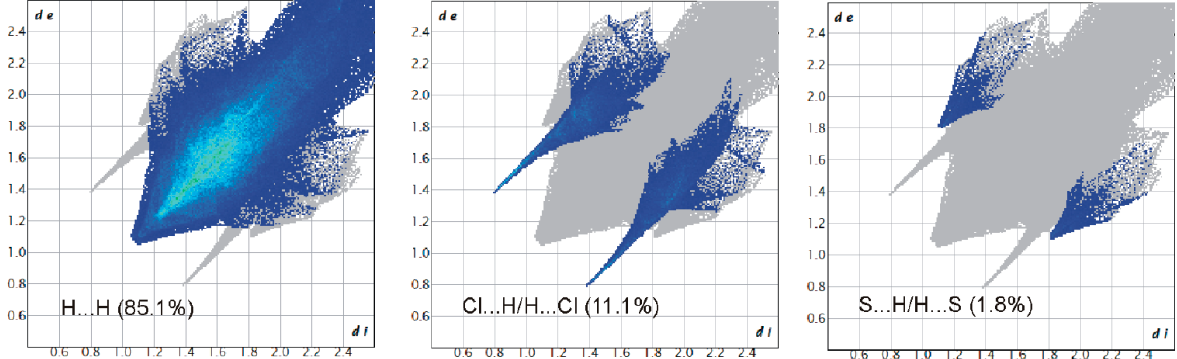
Figure 11. View of the three-dimensional Hirshfeld surface of 3 plotted over d norm in the range − 0.4772 to 2.1283.